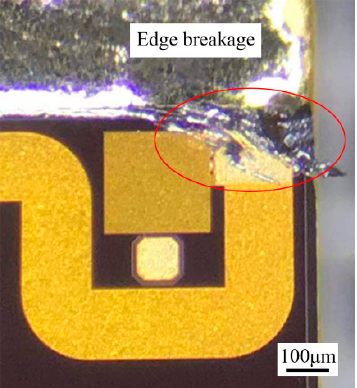
Figure 10. Schematic diagram of the microstructure evolution process of the Au/Ti/Au|Au-Sn joint: ( a ) initial state, ( b ) dissolution and diffusion between the metallization system and the Au-Sn solder, ( c ) formation of TiAu 4 , ( d ) nonisothermal solidification with the formation of Au 5 Sn, and ( e ) nonisothermal solidification with the formation of Au-Sn eutectic. However, 3D CT revealed the presence of a large number of voids in the brazed region (Figure 11). The samples with a high void content were separated by “hot-lifting” on a hot plate. A broad gray area of the MMIC was not wetted by the Au-Sn solder (Figure 12). The chemical compositions of the wetted and unwetted areas were detected by EDS (Figure 13). Compared with the wetted